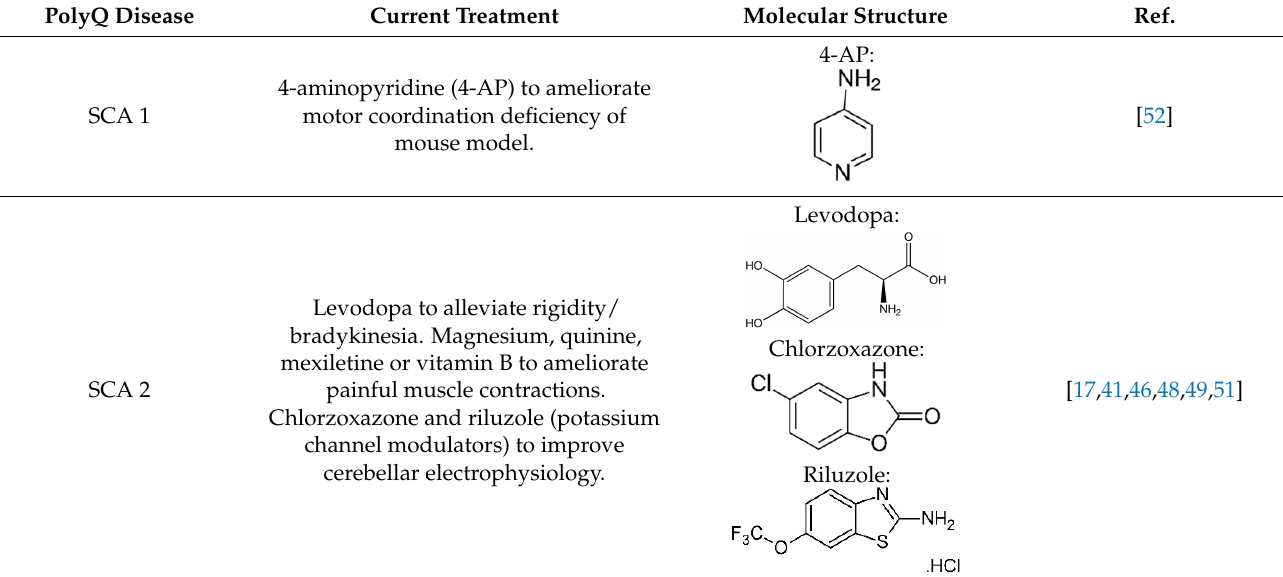
Table 2. Current pharmacological treatments for polyQ SCAs.